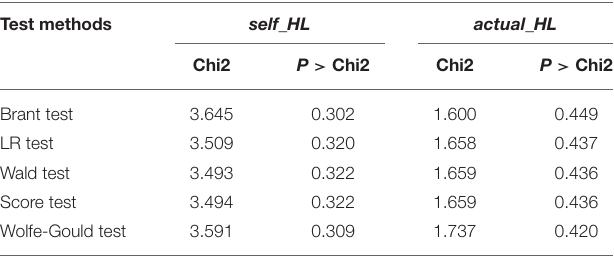
TABLE 5 | Parallel regression assumption test results. Test